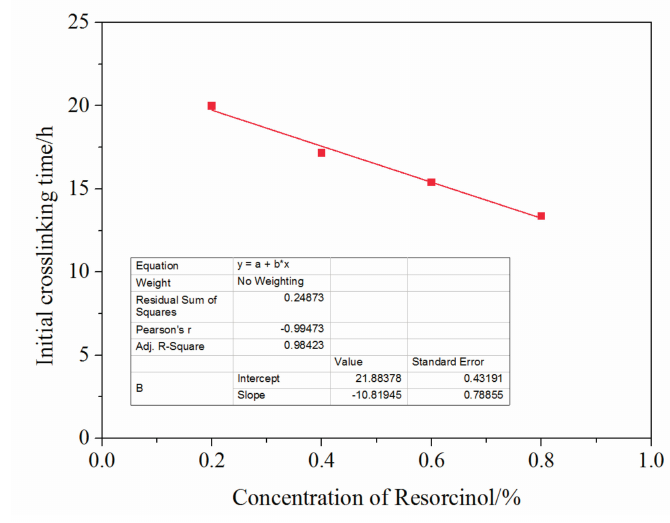
Figure 8. Effect of resorcinol concentration on initial gelation time of the polymer